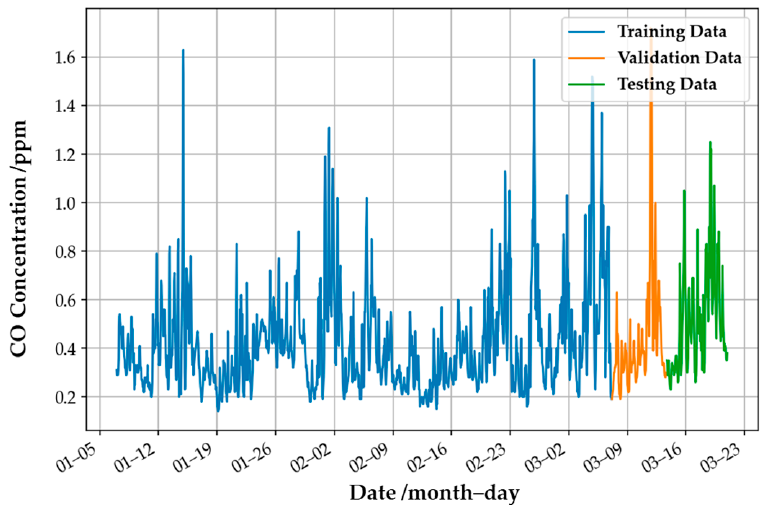
Figure 4. An example of the datasets for the training and testing phases. The CO gas concentration data were obtained from the EPA website.